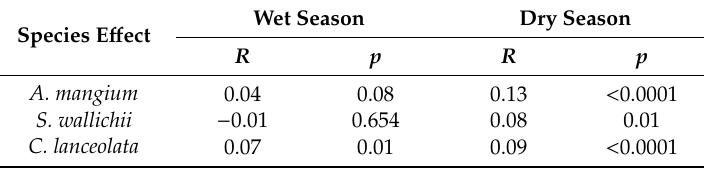
Table 7. E ff ects of temperature on the residual of the model in wet and dry